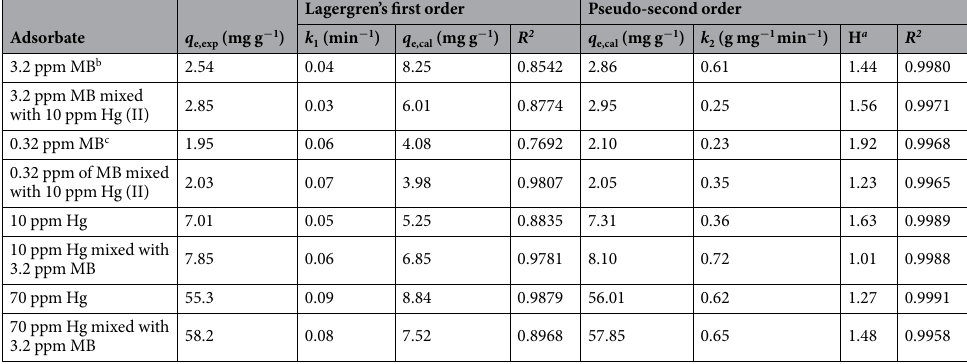
Table 2. Adsorption kinetic parameters for Lagergren models. a Initial adsorption rate, h = k 2 q e2 . b i.e. 1 × 10 − 5 M of MB. c i.e. 1 × 10 − 6 M of MB.